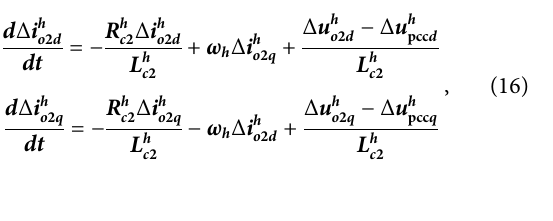
Frontiers in Energy Research |